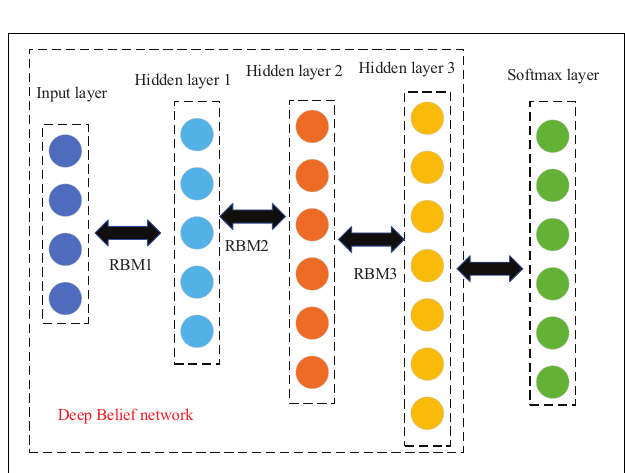
FIGURE 5 | The first-dimensional MFCC characteristic parameters of the guzheng music segment.